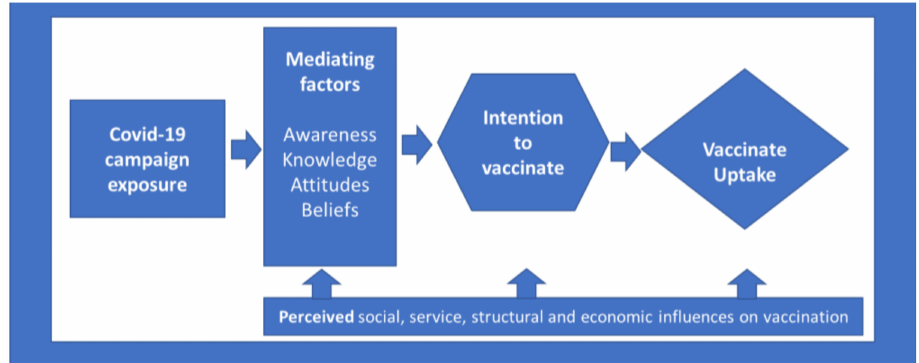
Figure 1. Social, service, structural, and economic influences on